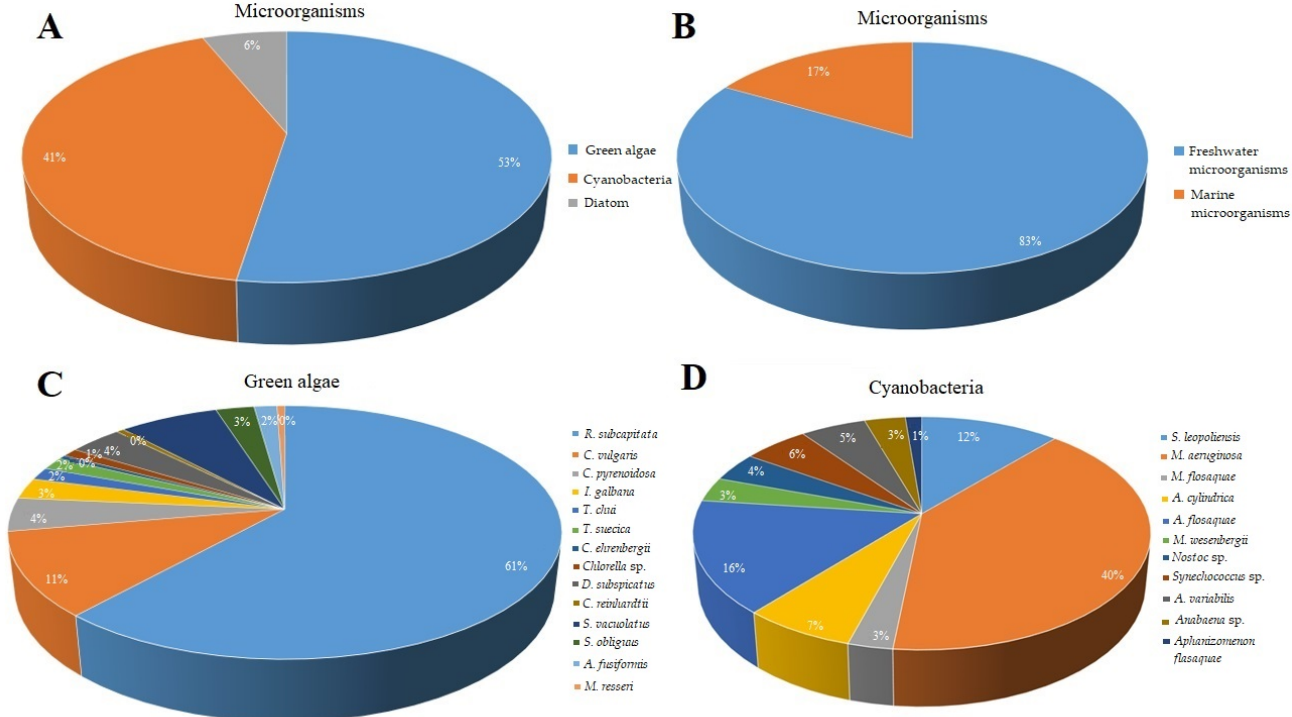
Figure 2. The percent distribution of the toxicological studies on antibiotics based on the number of EC 50 reports according to different algal groups (multiple data obtained in independent studies). A —green algae, cyanobacteria, diatom; B —freshwater vs. marine microorganisms; C —green algae; D —cyanobacteria.